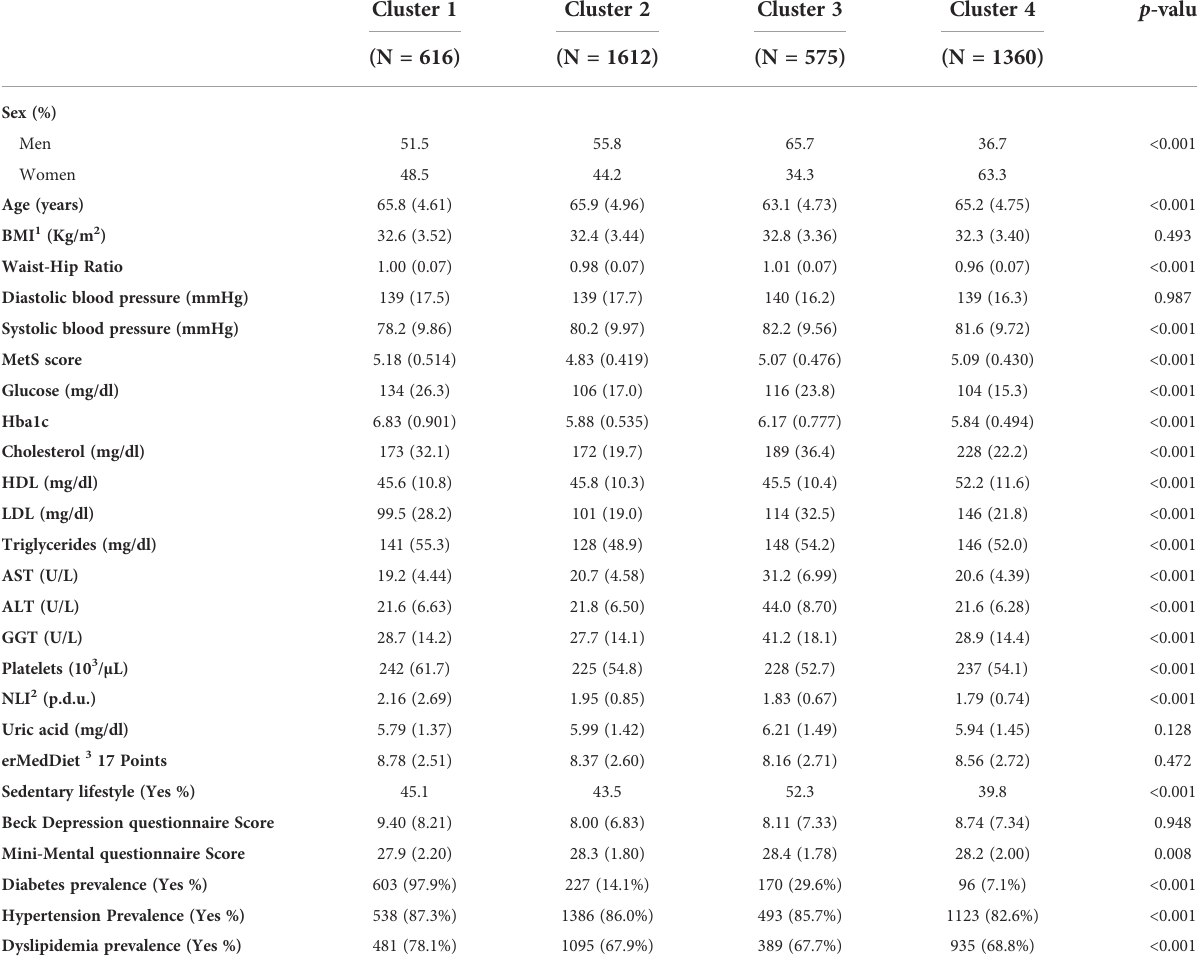
TABLE 3 Differences between clusters in anthropometric, psychosocial, biochemistry and disease prevalence parameters adjusted by sex, age and recruitment